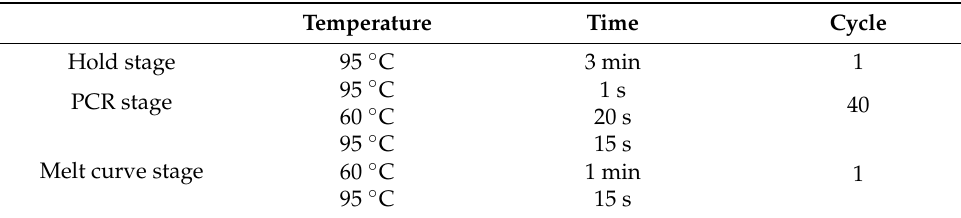
Table 5. PCR program. Temperature Time Cycle Hold